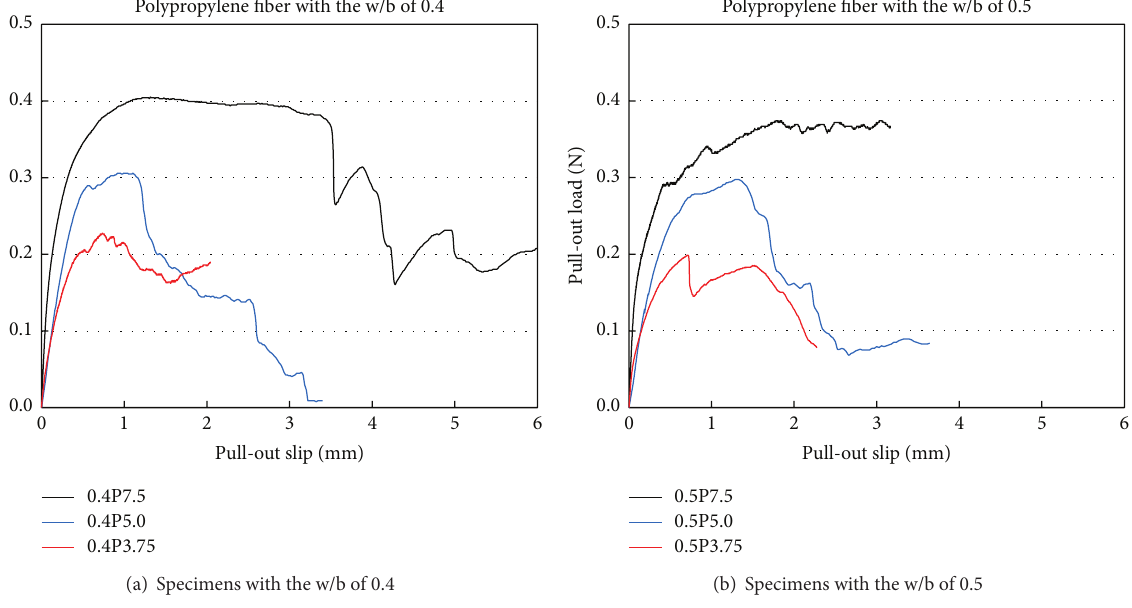
Figure 6: Pull-out load versus slip at the end for specimens with polypropylene fiber.